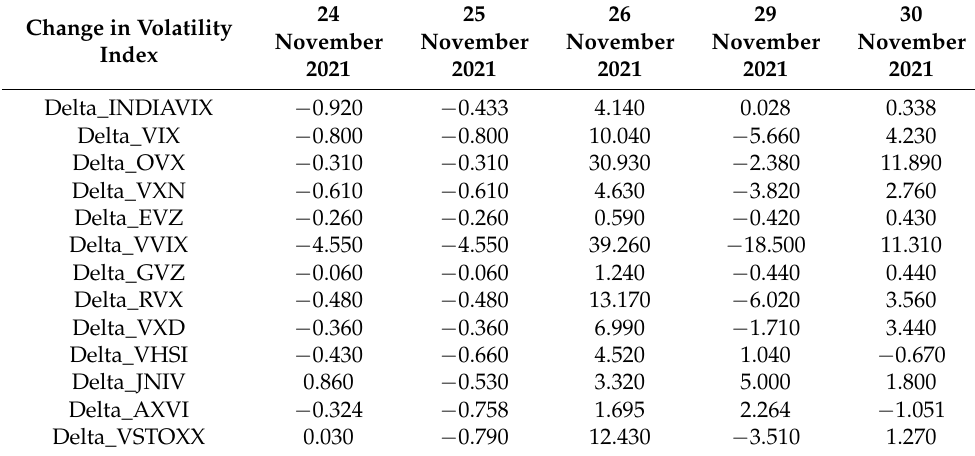
Table 1. Change in implied volatility indices due to the news of